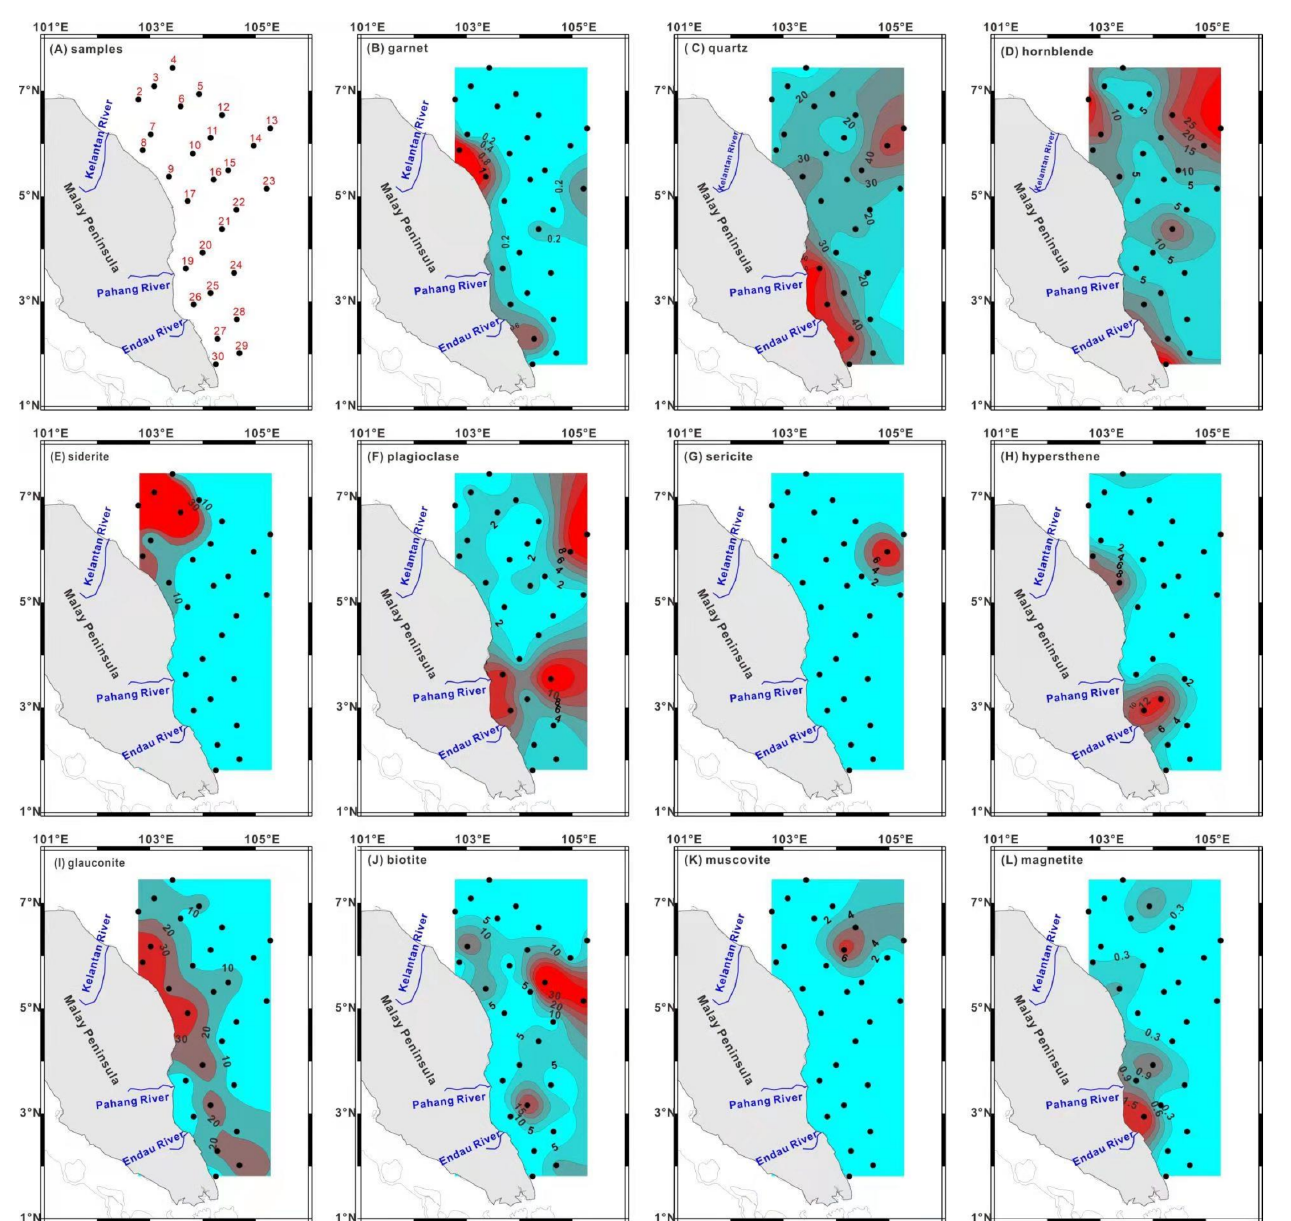
Figure 5. ( A ) Locations of surface sediments on the southwestern Sunda Shelf (dark dots) used for detrital mineral analyses, ( B ) garnet, ( C ) quartz, ( D ) hornblende, ( E ) siderite, ( F ) plagioclase, ( G ) sericite, ( H ) hypersthene, ( I ) glauconite, ( J ) biotite, ( K ) muscovite, and ( L )